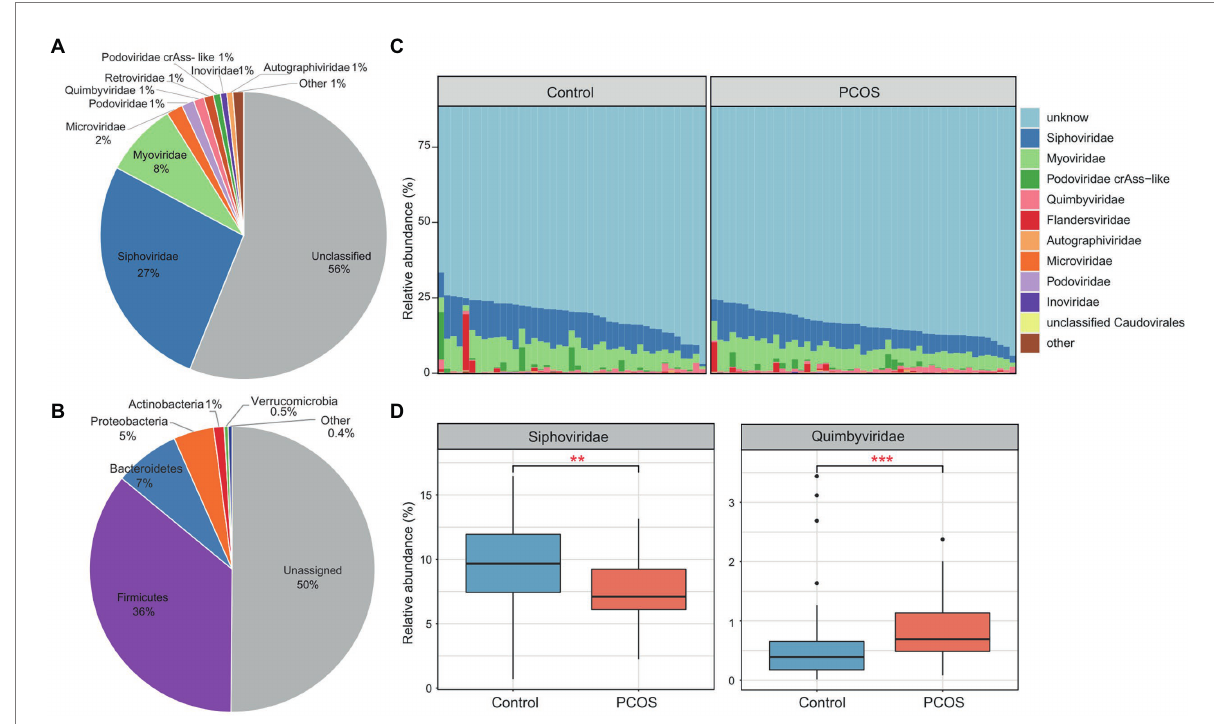
FIGURE 1 Summary of the gut virome in polycystic ovary syndrome (PCOS) patients and healthy controls. (A) The proportion of viral operational taxonomic units (vOTUs) that were assigned to viral taxa at the family level. (B) The proportion of vOTUs that are predicted to infect microbial hosts at the phylum level. (C) Bar plot showing the gut viral composition of all samples at the family level. Only the top 10 viral families with the highest abundance are shown. (D) Bar plot showing the relative abundance of differentially abundant viral families between the two groups. Boxes represent the interquartile range between the first and third quartiles, and the median (internal line). Whiskers denote the lowest and highest values within 1.5 times the range of the first and third quartiles, respectively; dots represent outlier samples beyond the whiskers. Wilcoxon rank-sum test with false discovery rate (FDR) correction: * q < 0.05; ** q < 0.01; *** q <